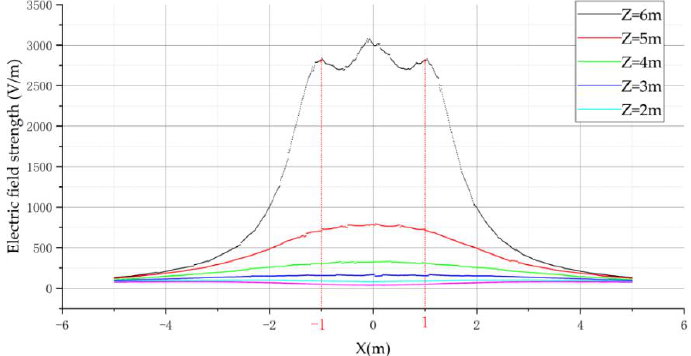
Figure 10. Electric field distribution curve of horizontal arrangement. The above electric field distribution curve shows that the three-phase transmission line with horizontal arrangement was symmetrically distributed on the left and right sides with the center-ward conductor as the symmetry axis. However, the variation of electric field intensity on the side of the center-directed wire was not completely monotonic, and the variation of electric field intensity satisfied the monotonic relationship in the regions of X < −1 and X > 1. Therefore, for the horizontal arrangement, the flight area of the UAV is the left side of the A-phase transmission line or the right side of the C-phase transmission line. In further analysis of the electric field distribution for the triangular arrangement, the electric field distribution curve is shown in Figure 11 below.